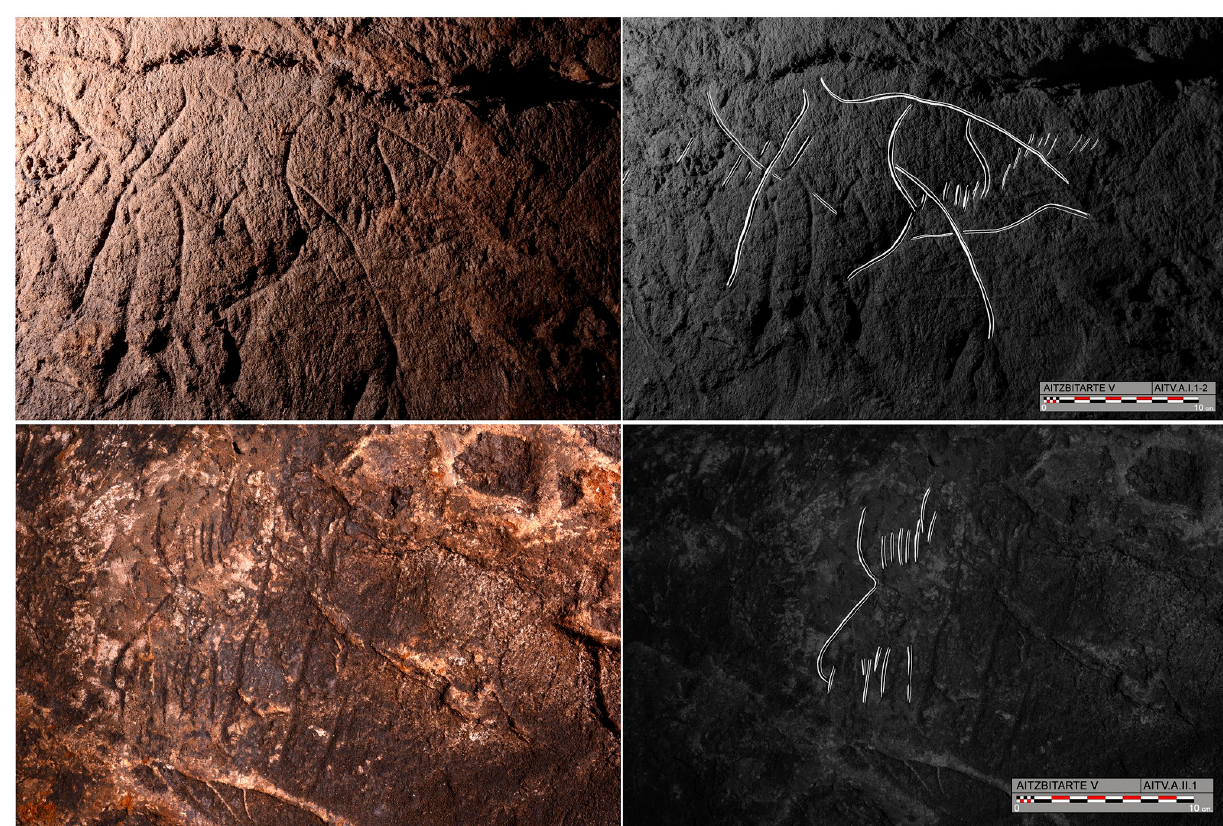
Fig 11. Photograph and tracing of bison A.I.1 and A.II.2, engraved in Sector A in Aitzbitarte Cave V (O. Rivero and D. Garate).